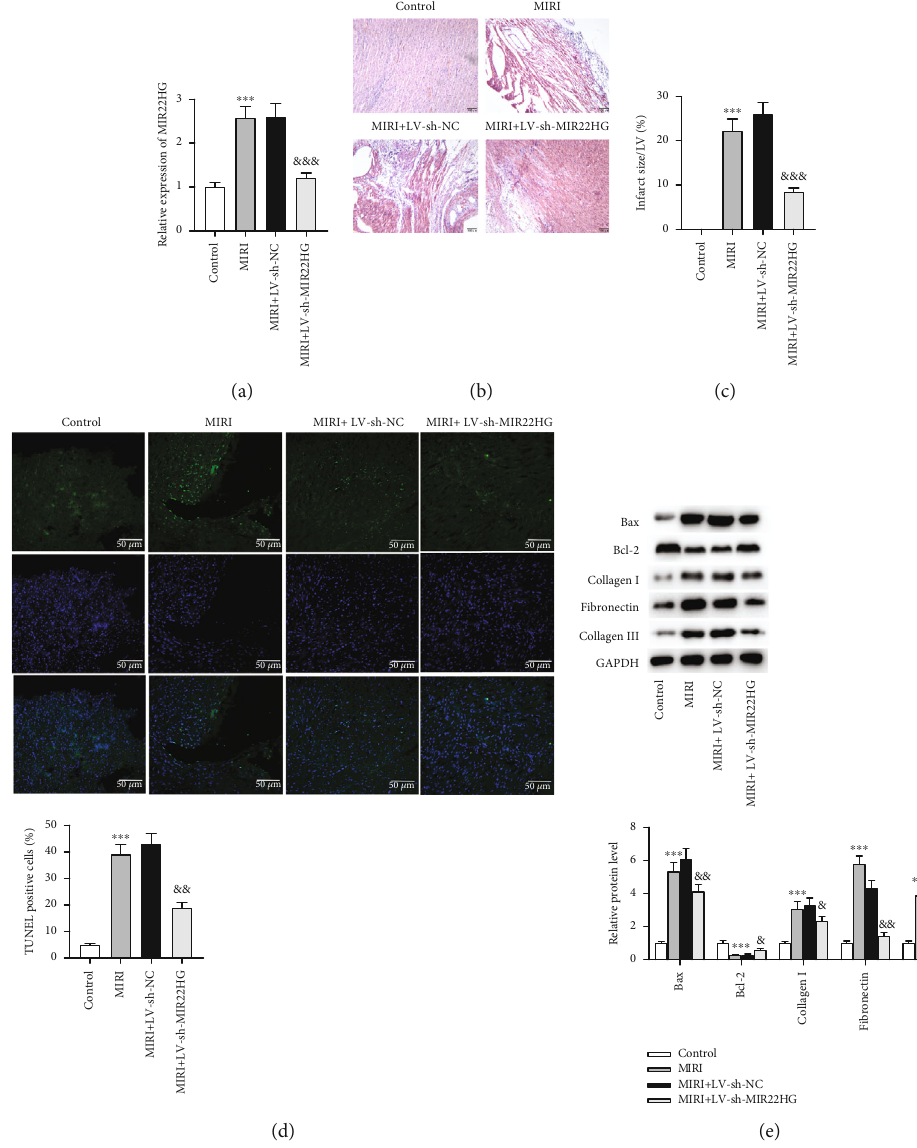
Figure 6: MIR22HG knockdown alleviates cardiomyocyte apoptosis in MIRI mice. (a) RT-qPCR was used to determine the expression of MIR22HG in MIRI mouse models ( n = 6 ). (b) HE staining of myocardium tissues ( n = 6 ). (c) The analysis of infarct size of MIRI mice ( n = 6 ). (d) TUNEL staining was used to assess the apoptosis of cardiomyocytes in each group ( n = 6 ). (e) The protein levels of Bax, Bcl-2, collagen I, fi bronectin, and collagen III in each group ( n = 6 ). N = 6 mice for each group. ∗∗∗ p < 0 : 001 vs. the control group or LV-sh-MIR22HG group; & p < 0 : 05 , && p < 0 : 01 , &&& p < 0 : 001 vs. the LV-sh-NC